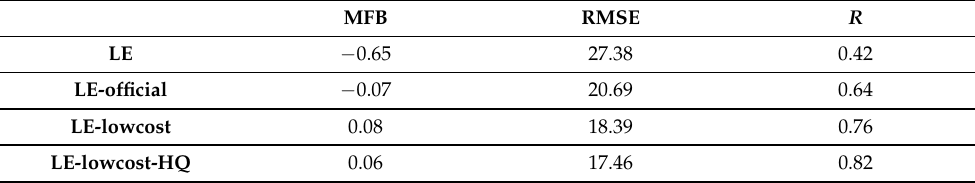
Table 4. Mean Fractional Bias, Root Mean Square Error and Pearson Correlation Coefficient for simulated PM 2.5 . Values are averaged over all the validation stations for the simulation period. MFB RMSE R LE −